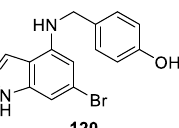
Figure 27. Chemical structure of 4-(((6-Bromo-1 H -indazol-4-yl)amino)methyl)phenol 120.